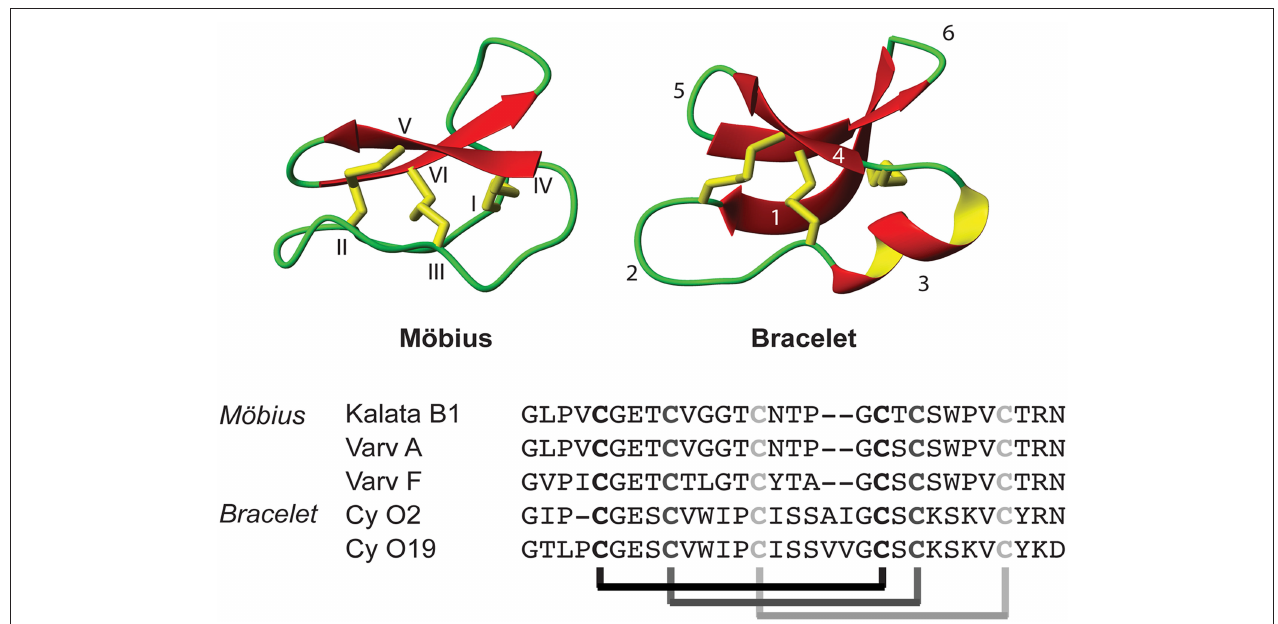
FIGURE 1 | Schematic structure of a Möbius and bracelet cyclotide, together with typical cyclotide sequences from both subfamilies. The structures are based on the PDB files 1NB1 and 2KNM. The abbreviated notation Cy O2 and Cy O19 stand for the cycloviolacins O2 and O19, respectively. Note the unique features of the CCK motif: a cyclic backbone with sequence loops (1–6) and three stabilizing disulfide bonds. These disulfides are arranged in a cystine knot: that is, two of the disulfides form a ring structure together with the backbone connecting the four cysteines (I–IV; II–V), while the third disulfide is threaded through the ring